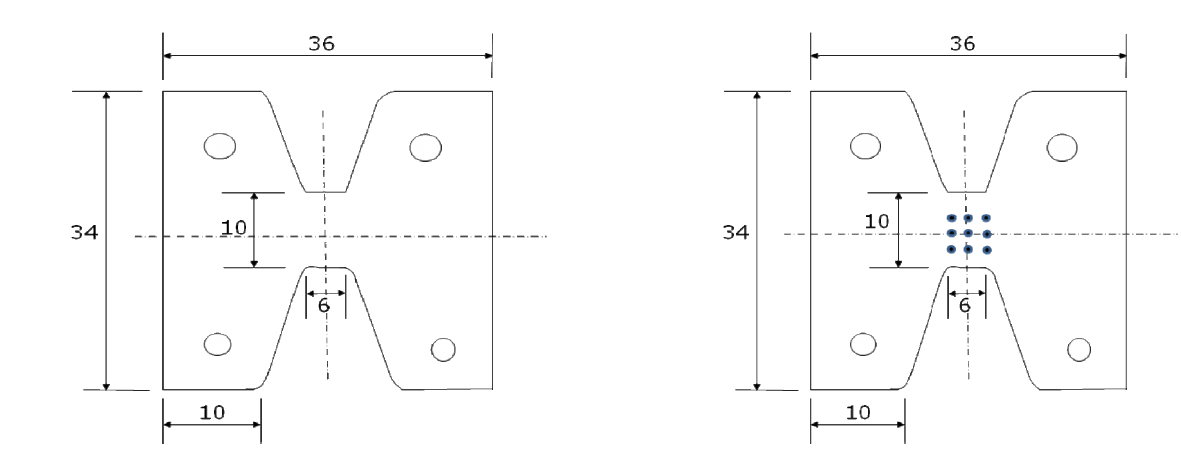
Figure 2: Flat square specimen (thickness 1mm.) Figure 3: Square specimen with array of